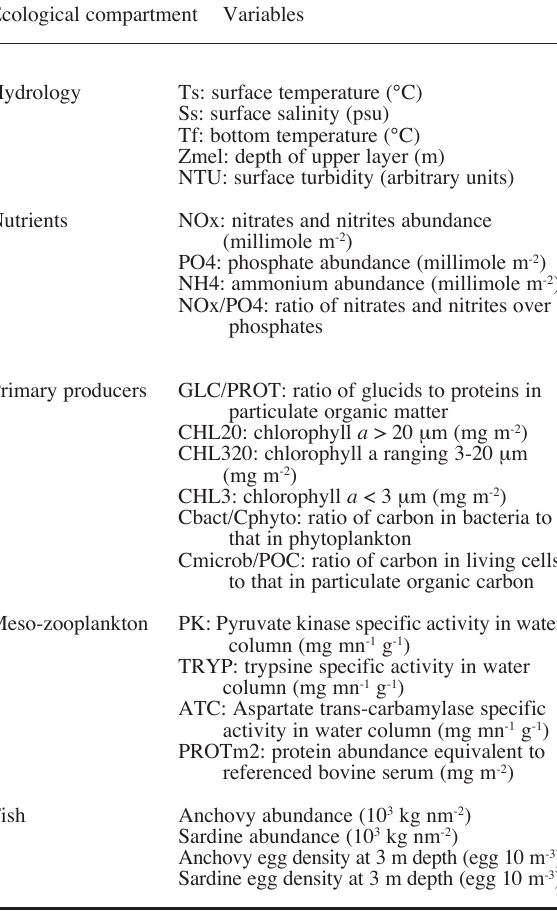
T ABLE 1. – List of variables used in the present work in the differ- ent ecological compartments. All variables were measured except Cbact/Cphyto, which was estimated by using standard carbon content per cell taken from the literature. Ecological